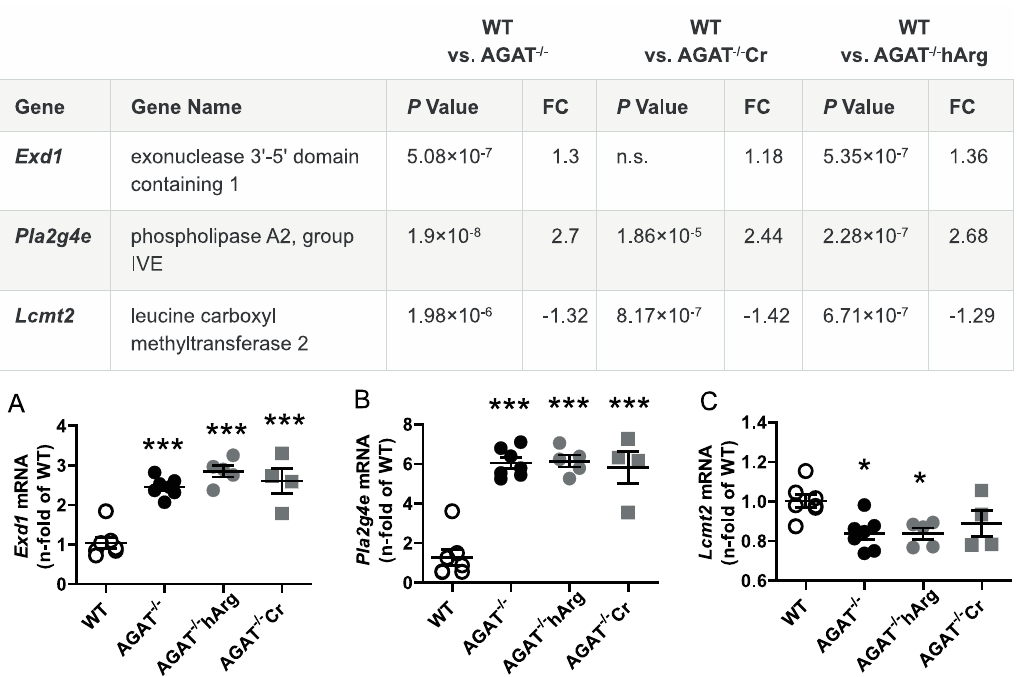
Figure 5. Validation of potential AGAT ‐ dependent candidate genes by qPCR. Relative mRNA expression of Exd1 (A), Pla2g4e (B) and Lcmt2 (C) in the brain. Each data point represents an individual mouse. * p < 0.05 and *** p < 0.001 versus WT. WT ( n = 7), AGAT − / − ( n = 7), AGAT − / − hArg ( n = 5), AGAT − / − Cr ( n = 4). The table shows the respective microarray data. Abbreviations: FC, fold change; n.s., not significant.